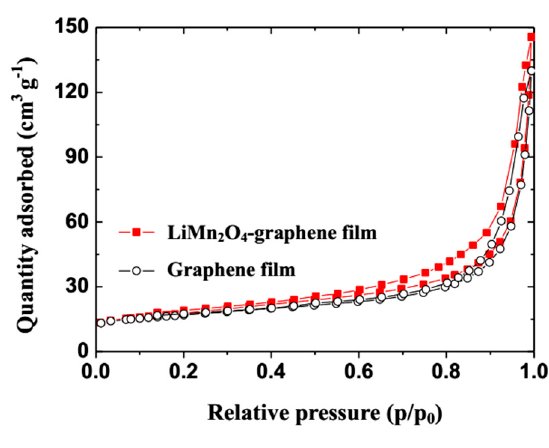
Figure 5. The N 2 isotherm adsorption and desorption curves of the graphene film and the LiMn 2 O 4 -graphene film.